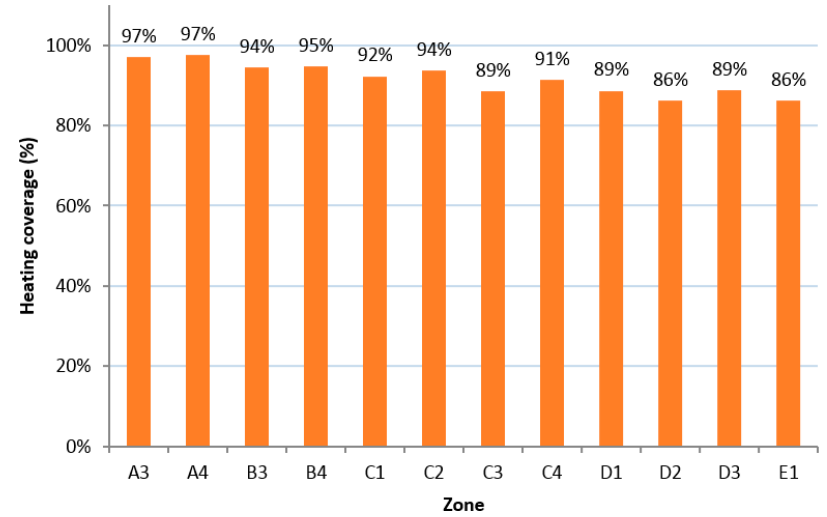
Figure 10. Annual heating coverage comparison for the different climatic zones.